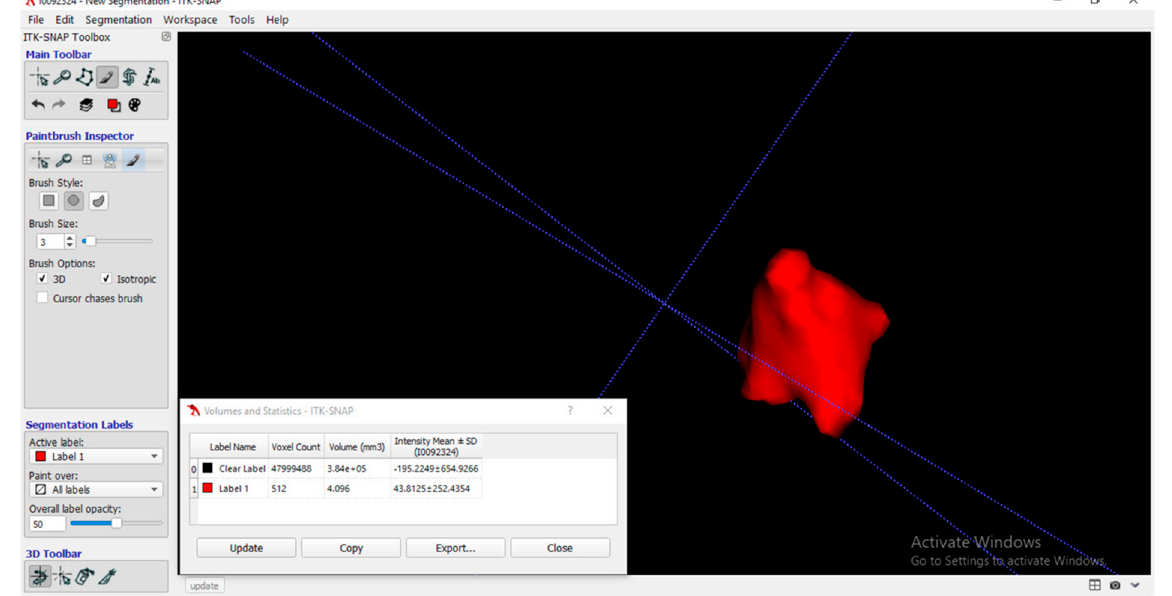
Figure 1. Three-dimensional volume analysis using ITK-SNAP software. All pre- and postoperative CBCT scans were taken by a single trained technician with fixed radiographic parameters of exposure time, kilovoltage, milliamperes, field of view and voxel size.